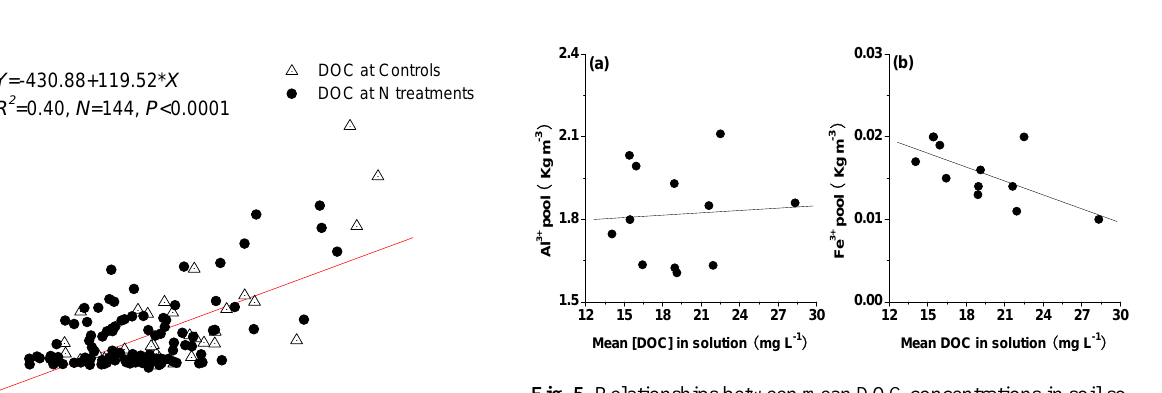
Fig. 5. Relationships between mean DOC concentrations in soil so- lution and soil extractable Al ( a ; Y = 1 . 76 + 0 . 003 · X , R 2 = 0 . 004, P = 0 . 84) and Fe ( b ; Y = 0 . 026 − 5 . 62 × 10 − 4 · X , R 2 = 0 . 42, P = 0 . 023) pools in upper 0–20cm mineral